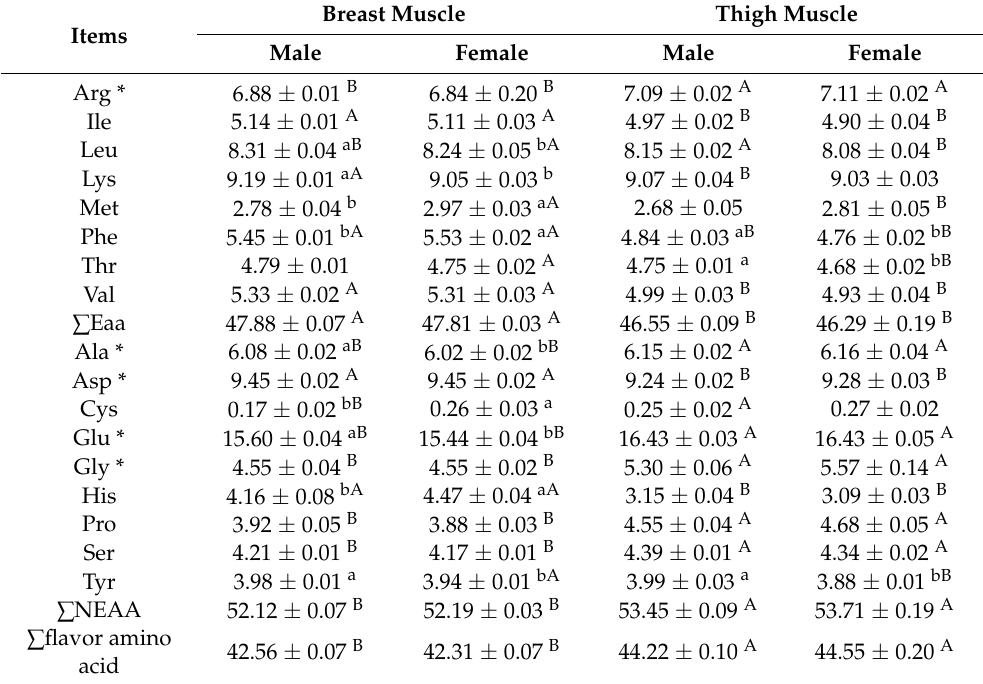
Table 3. The contents of amino acids in breast and thigh muscles of Wuliangshan Black-bone chickens (%). Breast Muscle Thigh Items